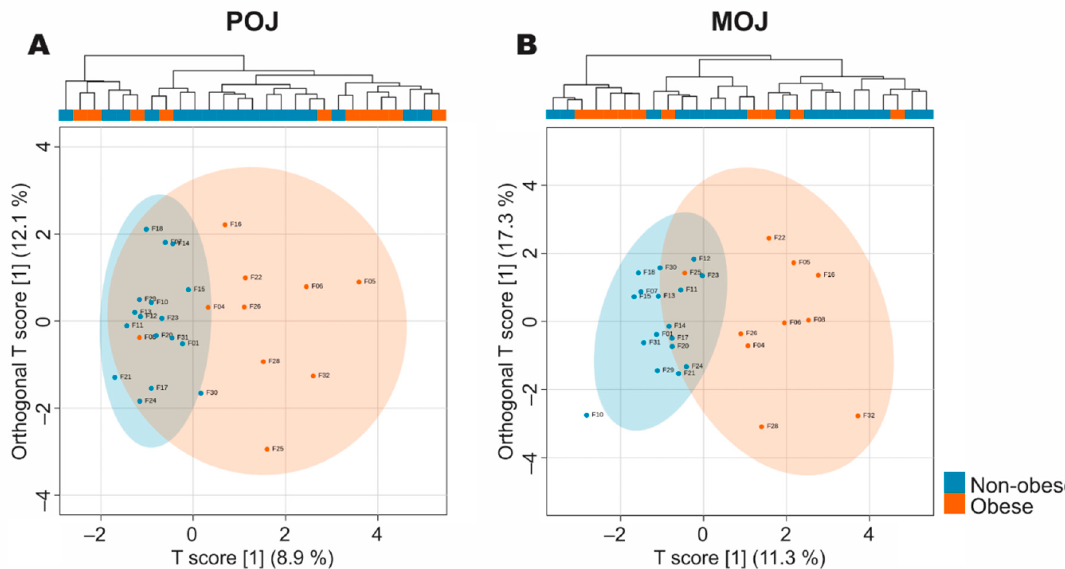
Figure 1. Orthogonal projections to latent structures discriminant analysis (oPLS-DA) of phase II flavanone metabolites excreted in urine 24 h (four collected intervals) after the consumption of ( A ) Pera orange juice (POJ) and ( B ) Moro orange juice (MOJ) in individuals with non-obese and obese BMI values (n = 17 non-obese and 10 obese volunteers).